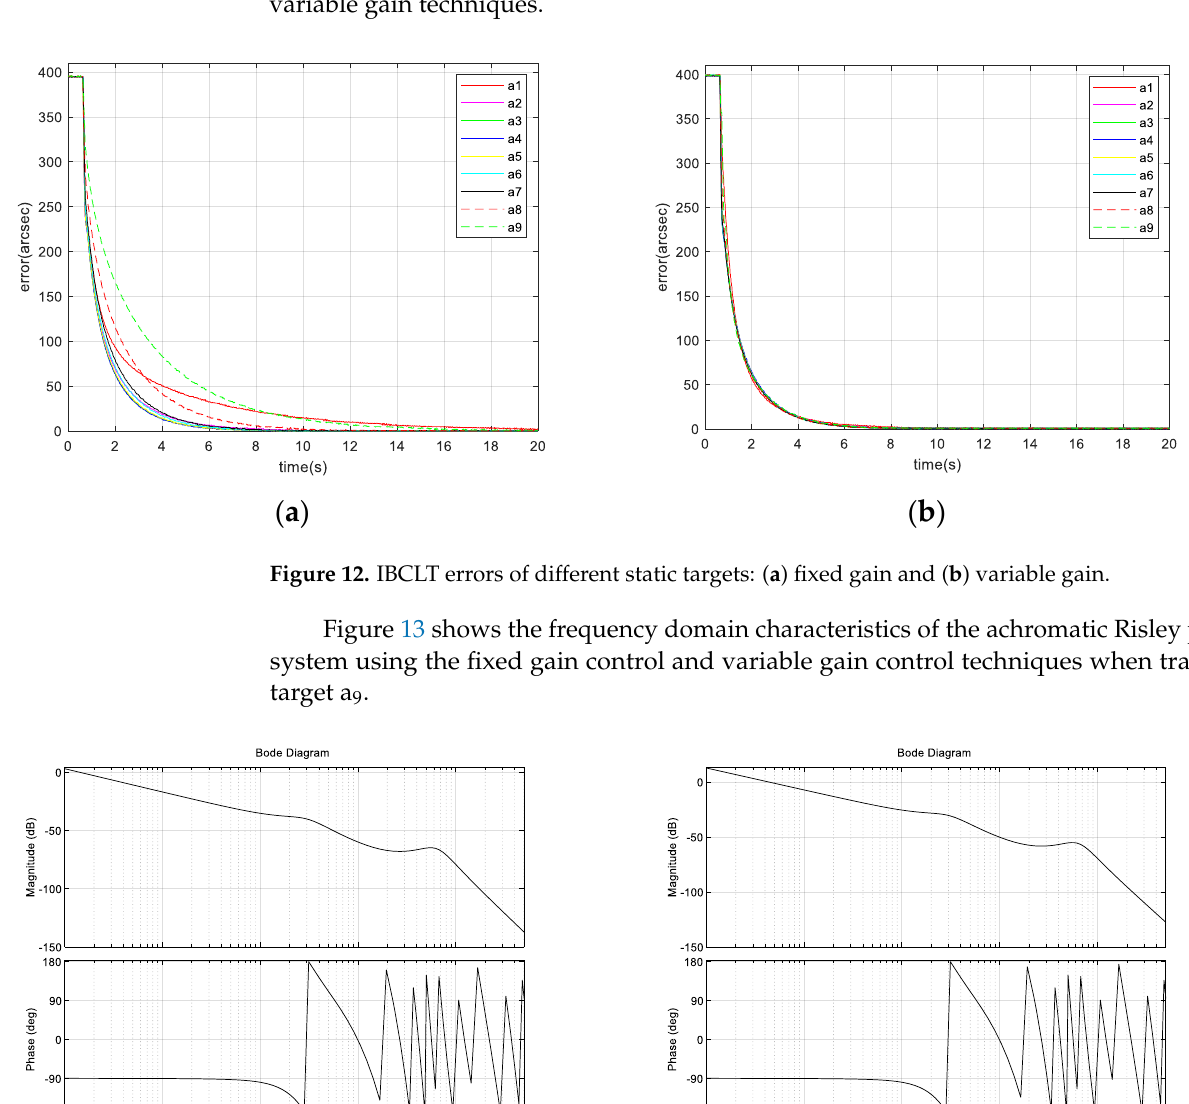
Table 2. Rising time of dynamic response for closed-loop tracking of different target.